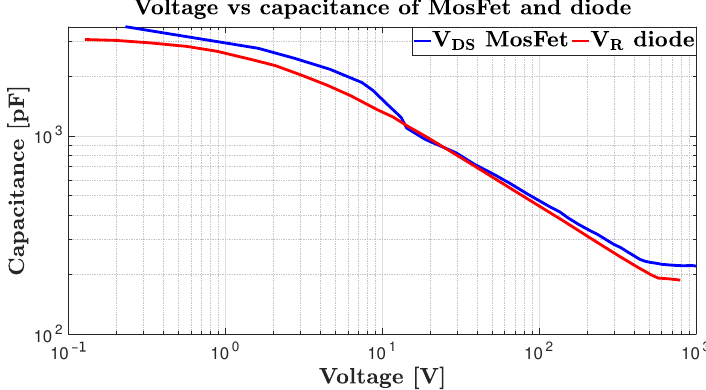
Figure 3. C oss and C j variations for SiC MOSFETs (C2M0025120D) and Diode (FFSH50120A).